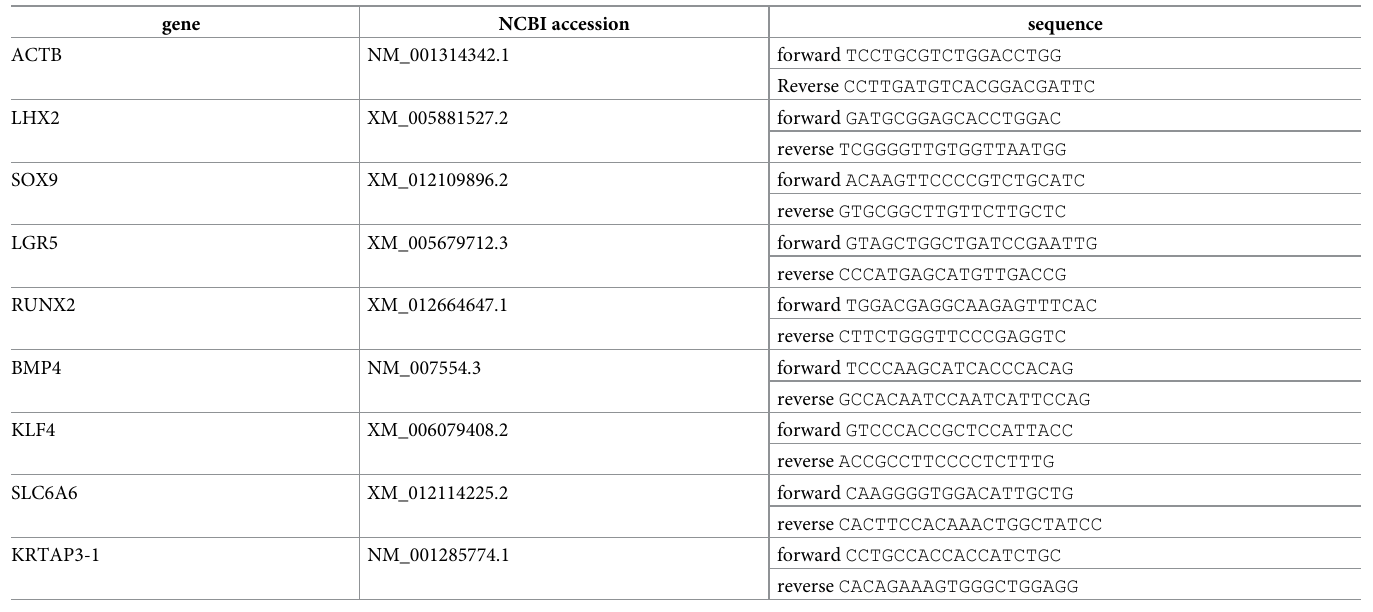
Table 1. Primer sequences for qRT-PCR.